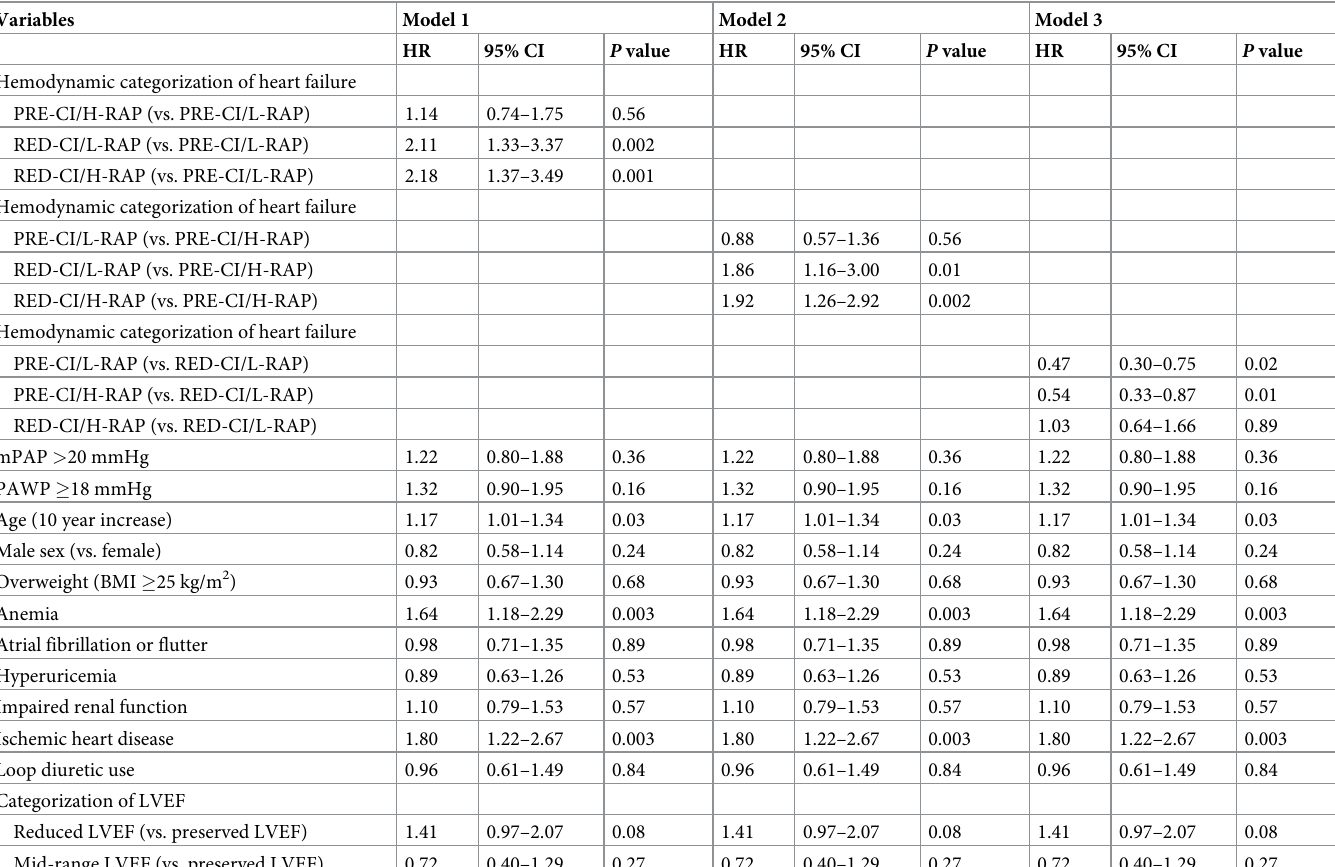
Table 4. Multivariate Cox regression analysis predicting primary